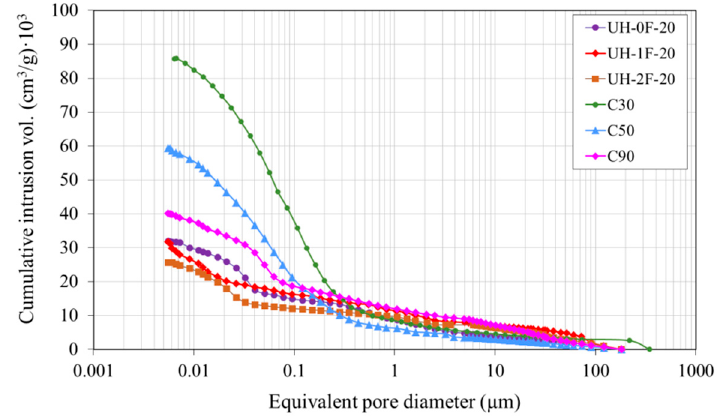
Figure 11. Cumulative pore size distribution.